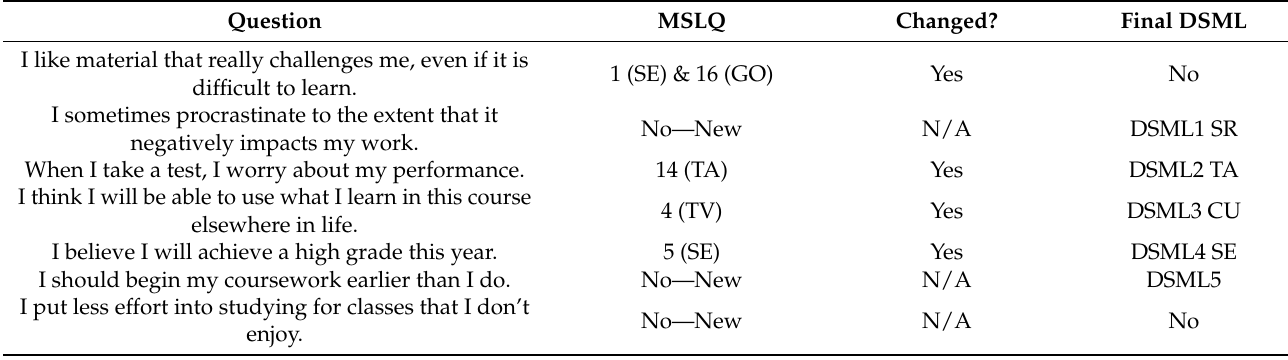
Table A1. DSML Measure with